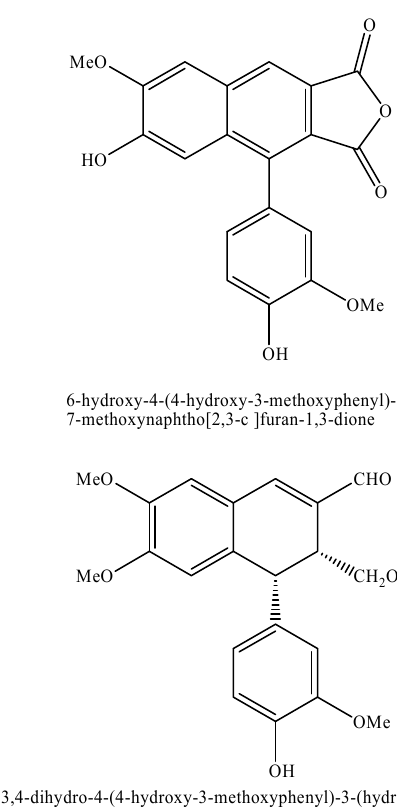
Figure 23. Isolated nor -lignans in the plant kingdom—part 22.